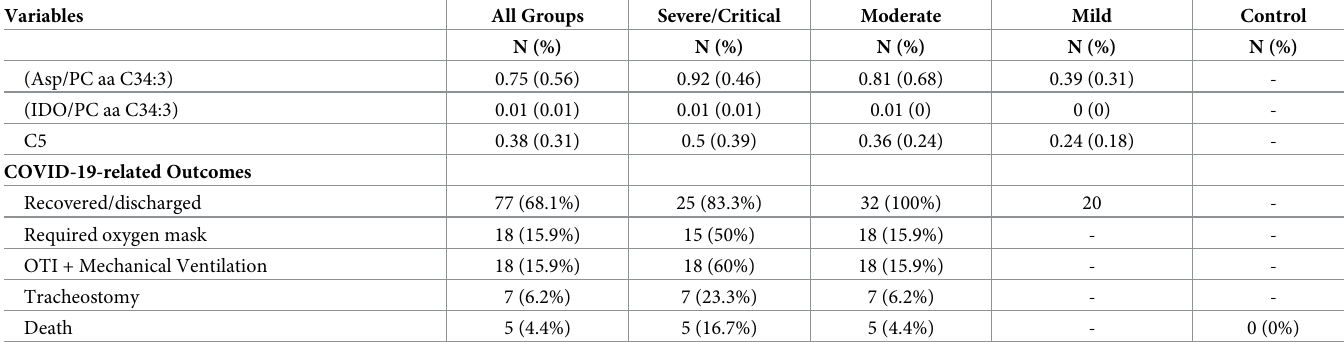
cycle ratio of Citrulline/Ornithine [30] the receiver operator curve (ROC) AUC = 0.95 (95% CI 0.87–0.99) provides a more discriminating measure of disease severity confirming the multi-factorial nature of effective response to Covid-19. Multivariate regression models were fit for each of four outcomes (moderate/severe vs. mild COVID-19); need for ventilator; complications besides pneumonia; and death), with independent variables including the metabolite measured, controlled for age, sex, and BMI. Models could not be run for several of the outcomes due to low numbers. However, our find- ings in Table 3 indicate that the ratio of glutamate and PC ae C34:3 was significantly positively associated with risk of developing moderate/severe COVID (OR = 1.283, 95% CI = 1.07, 1.68). The ratio of (Kynurenine/Tryptophan)/(Citrulline/Ornithine) (Kyn/Trp)/(Cit/Orn) was asso- ciated with increased risk of complications other than pneumonia (OR = 73.9, 95% CI 8.2, 1282.7) and need for ventilator (OR = 20.6, 95% CI = 3.1, 206.9). Valeryl-carnitine (C5) levels Table 2. The most discriminating lipid ratios obtained from the data set of 186 metabolites. METABOLITE RATIOS